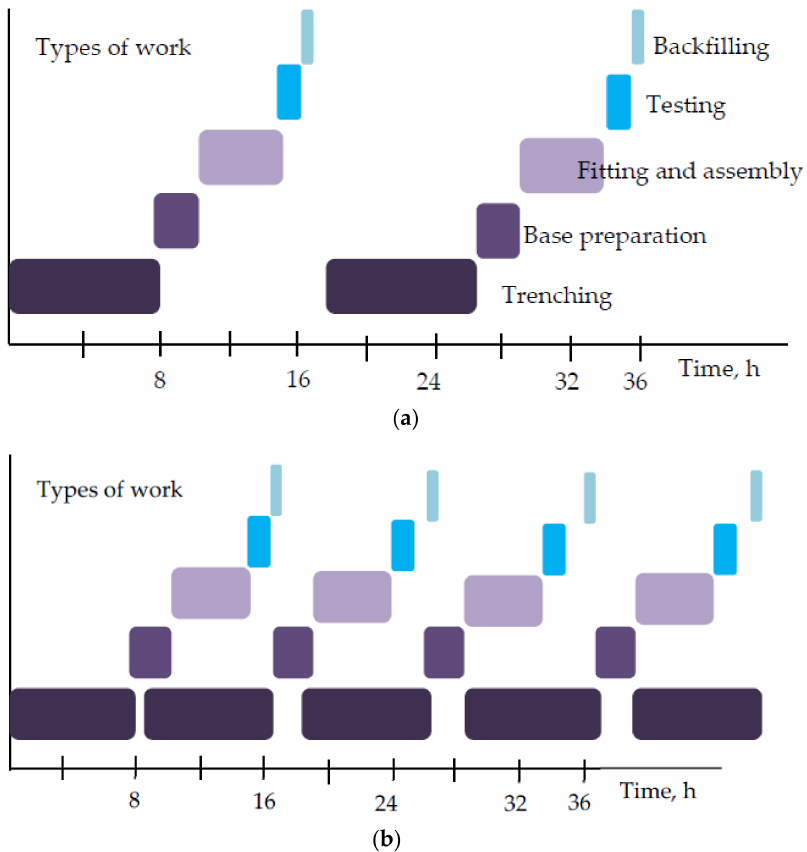
Figure 6. ( a ) Heat pipeline laying before reorganization; ( b ) heat pipeline laying after